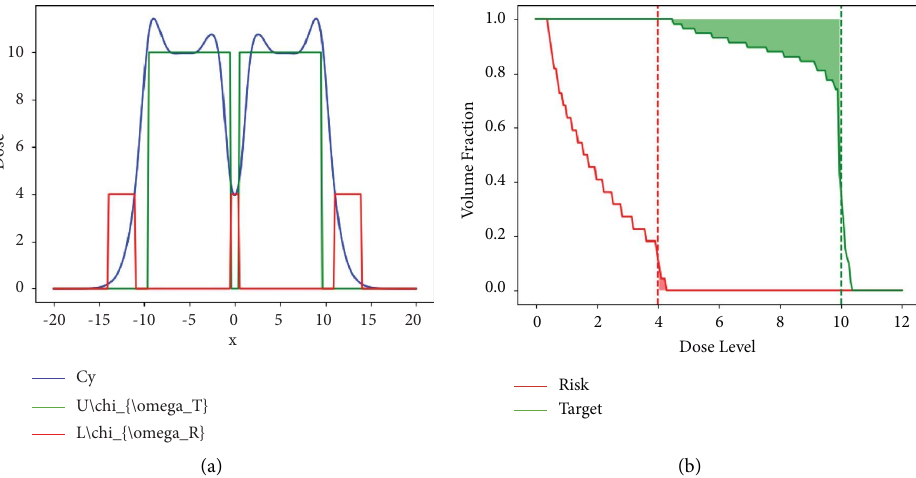
Figure 4: Dose information for dose-constrained equation (3) with 􏽥 β target level R . (b) Dose volume histogram for risk w R and target region w T